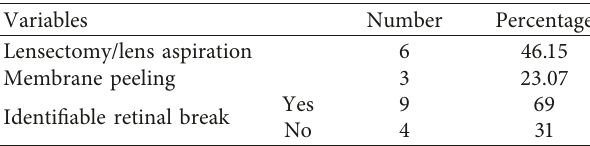
Table 2: Surgical record ( N �